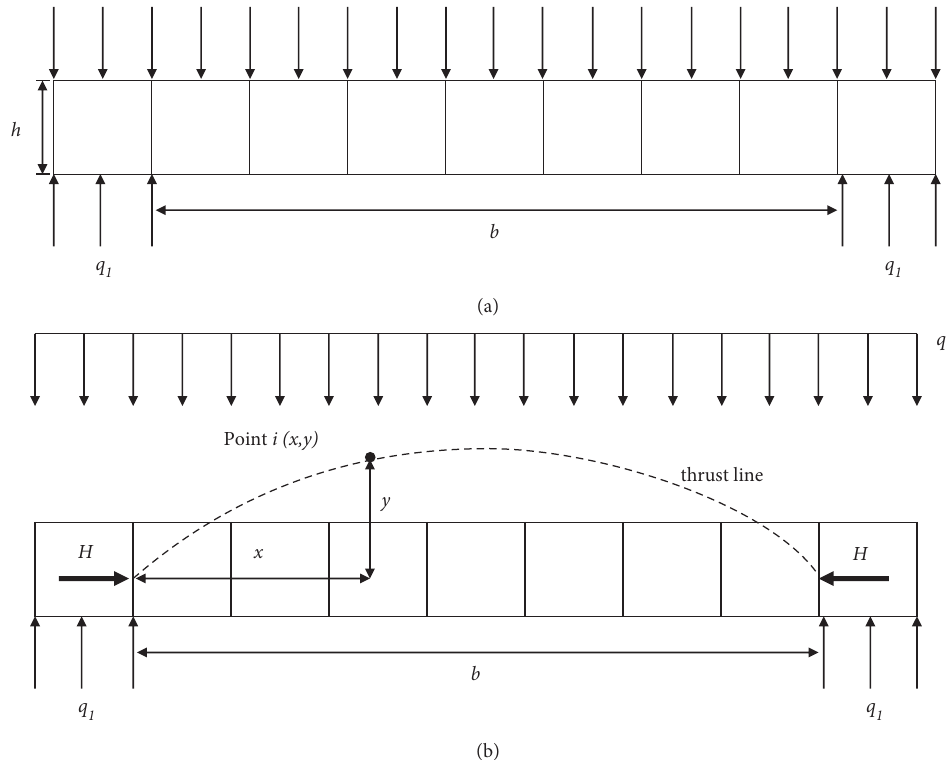
Figure 4: The mechanical model of the loosened zone. (a) The slip failure; (b) The snap-through